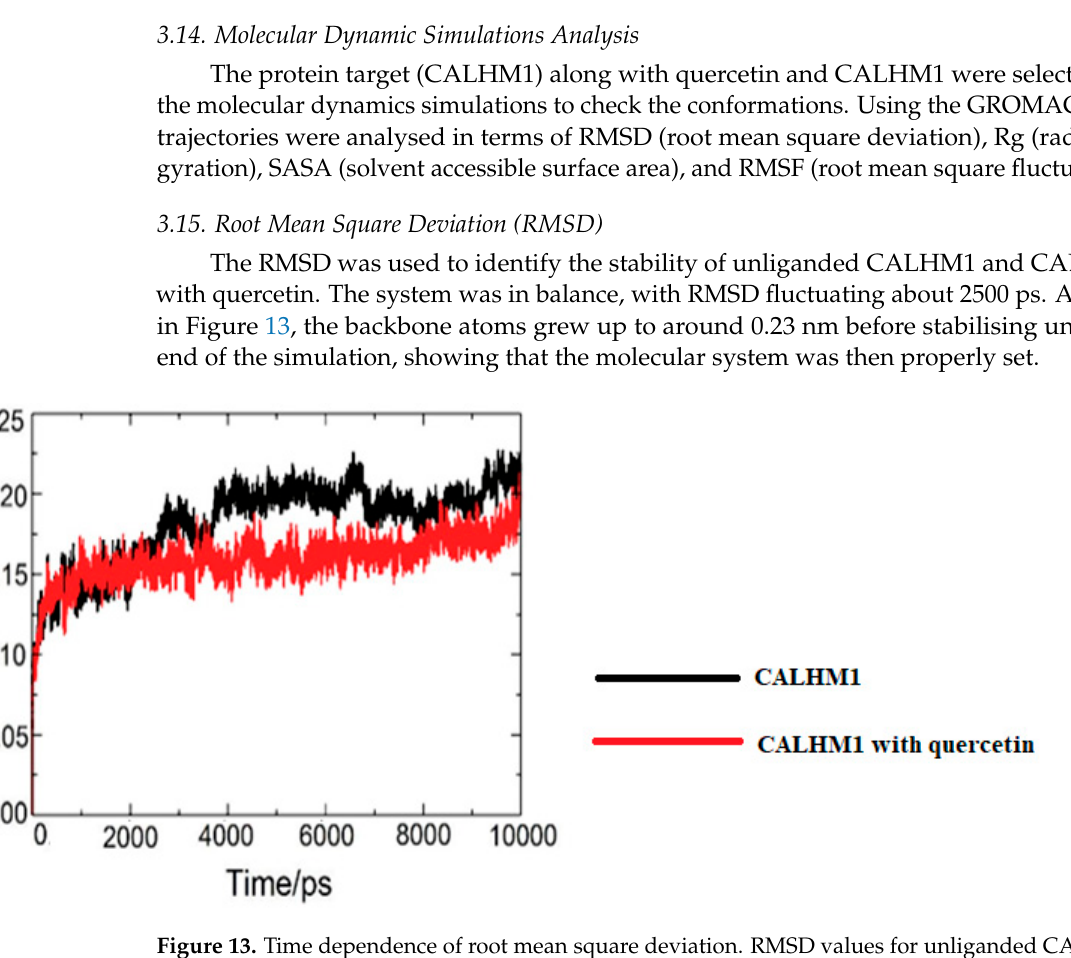
Figure 13. Time dependence of root mean square deviation. RMSD values for unliganded CALHM1 and CALHM1–quercetin complex.